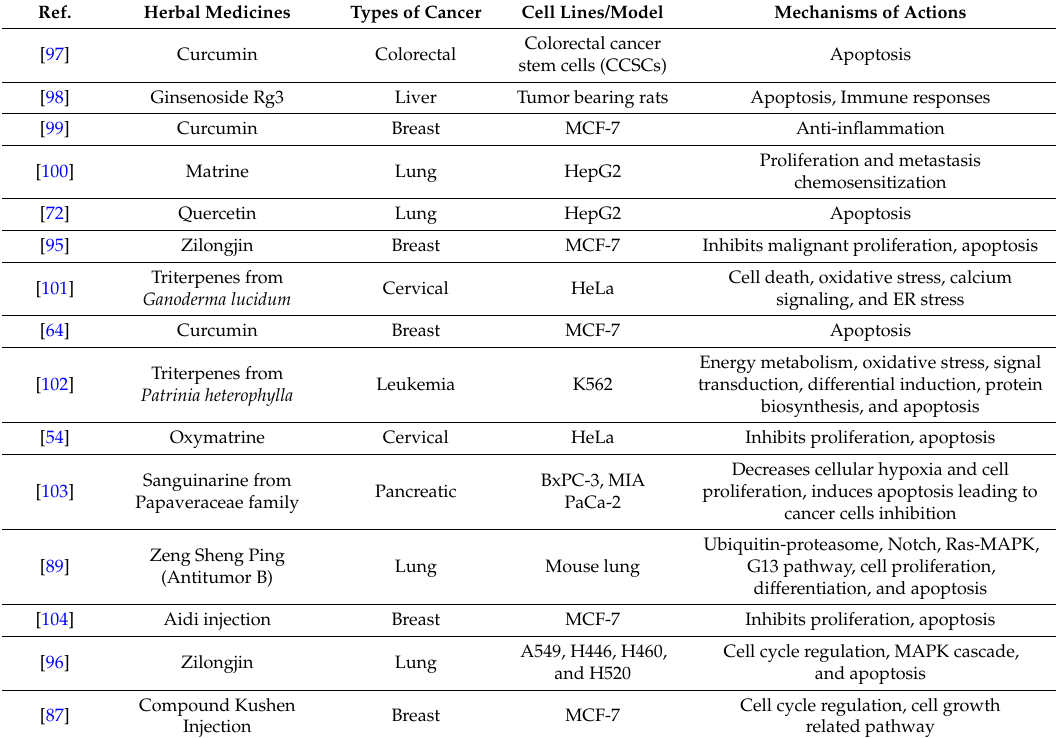
Table 1. Reported therapeutic effects by single or mixtures of natural compounds in different stages of cellular